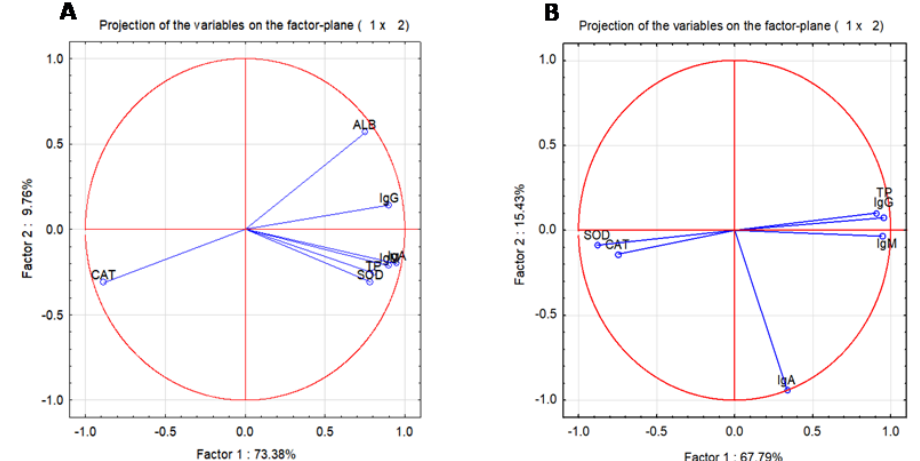
Figure 5. Correlation diagrams between serum ( A ) and lymphocytes parameters ( B ) investigated using the principal component analysis (PCA) model. In serum, a negative correlation between CAT and immunoglobulins and a positive correlation between SOD and immunoglobulins demonstrate that the oxidative stress directly influences antibodies’ secretion, whereas in in vitro tests, CAT and SOD were negatively correlated with antibodies’ secretion. As in the in vivo models, when the oxidative stress is decreased, the immunoglobulin secretion is amplified.